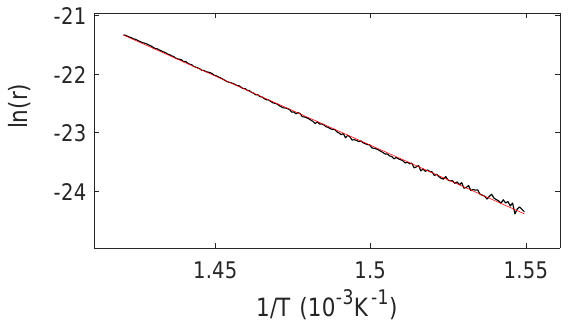
Figure 9. The logarithm of the desorption rate plotted versus 1/T for desorption of CO from a sample of six ethylene exposure cycles. The straight line is a linear fit to the data over a narrow temperature region and is used to estimate desorption